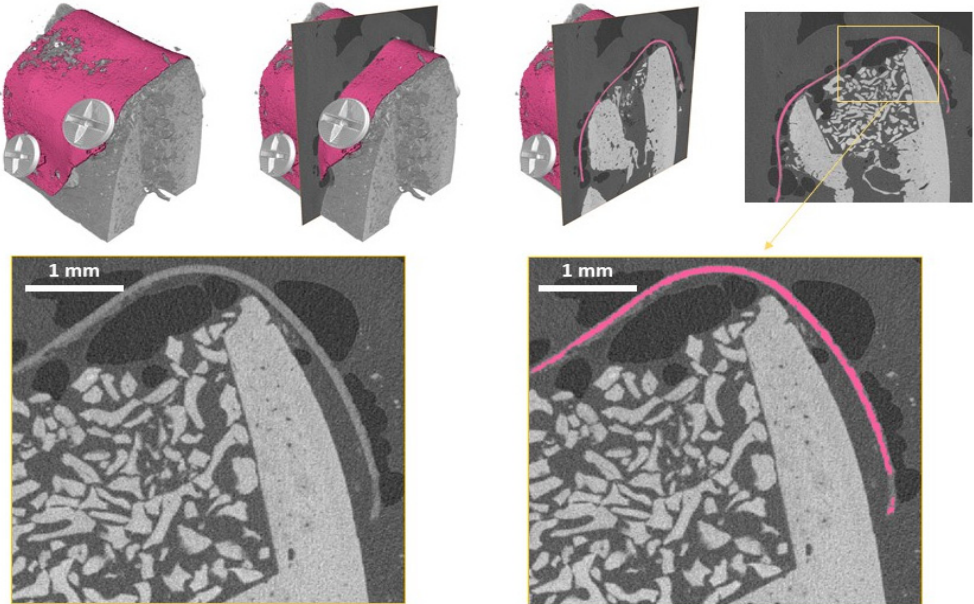
Figure 6. Representative images of the segmented magnesium metal membrane (pink) and virtual slices (gray) at the 1-week timepoint to illustrate the allocation of remnant metallic magnesium to gray values and image properties. Small gas cavities can be seen around the membrane, which are resultant from hydrogen gas development during the degradation process. Magnesium salts can also be seen retaining the shape and position of the membrane and are distinguished from the metallic magnesium using the employed segmentation technique within the AVIZO software (Thermo Fisher Scientific, USA).